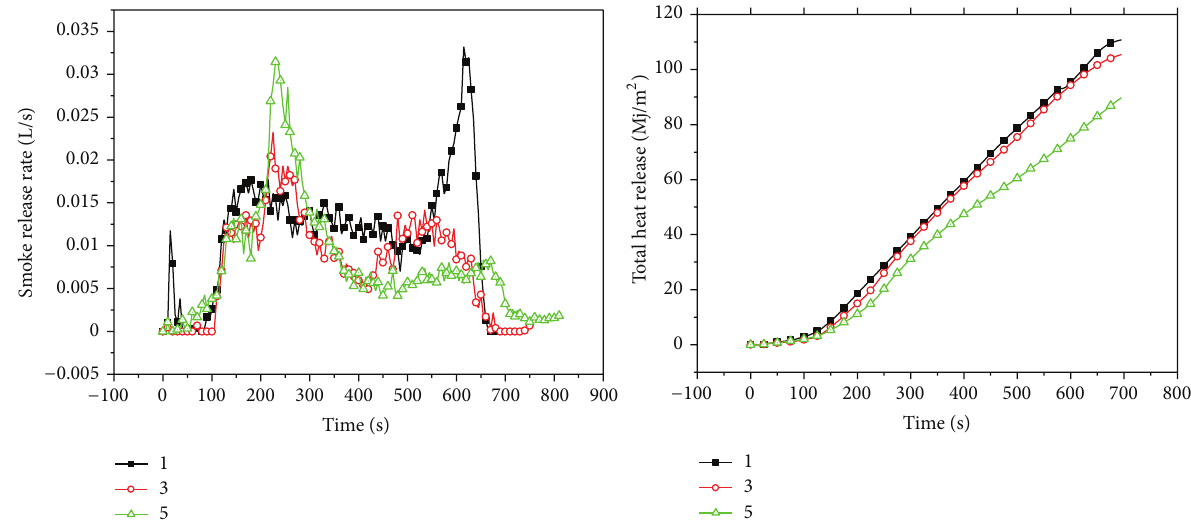
Figure 5: SRR and THR curves as a function of time for PP/27%IFR, PP/27%IFR/3%PETA, and PP/27%IFR/6%PETA.